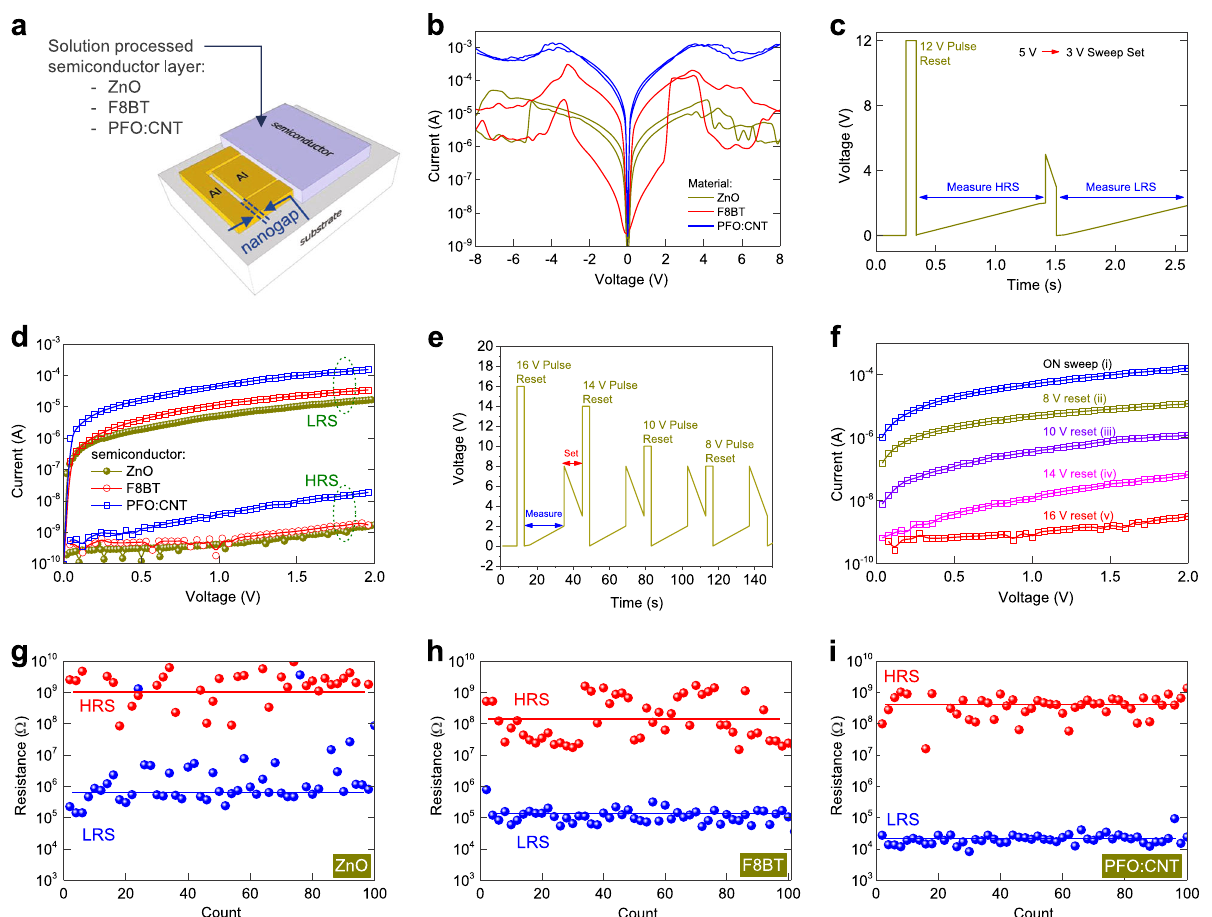
Fig. 5 Non-volatile memory nanogap devices developed using a-Lith. a Schematic of the memory device architecture fabricated via a-Lith. b I – V characteristics measured for nanogap devices based on ZnO, F8BT, and PFO:CNT. c Bias waveform used to programme the device resistance state and for subsequent endurance evaluation: The reset voltage (12 V pulse) applied for ≈ 100 ms puts the device into the HRS, after which the current is measured between 0 and 2 V. The set voltage (5 – 3 V sweep) puts the device into the LRS, after which current is again measured in the range between 0 and 2 V. d I – V curves depicting the low-resistance state (LRS) and high-resistance state (HRS) of the three device types tested using the waveform shown in c to switch between states and measure. e Bias waveform used to perform the multilevel programming of the device resistance state. f Multilevel switching characteristics measured from a representative PFO:CNT-based nanogap device. Endurance characteristics of g ZnO, h F8BT, i PFO:CNT nanogap devices obtained over 100 switching cycles. Resistance ratios in